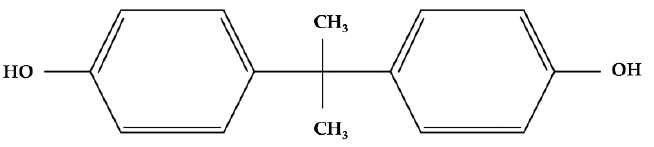
Figure 1. Structure of bisphenol A (BPA).